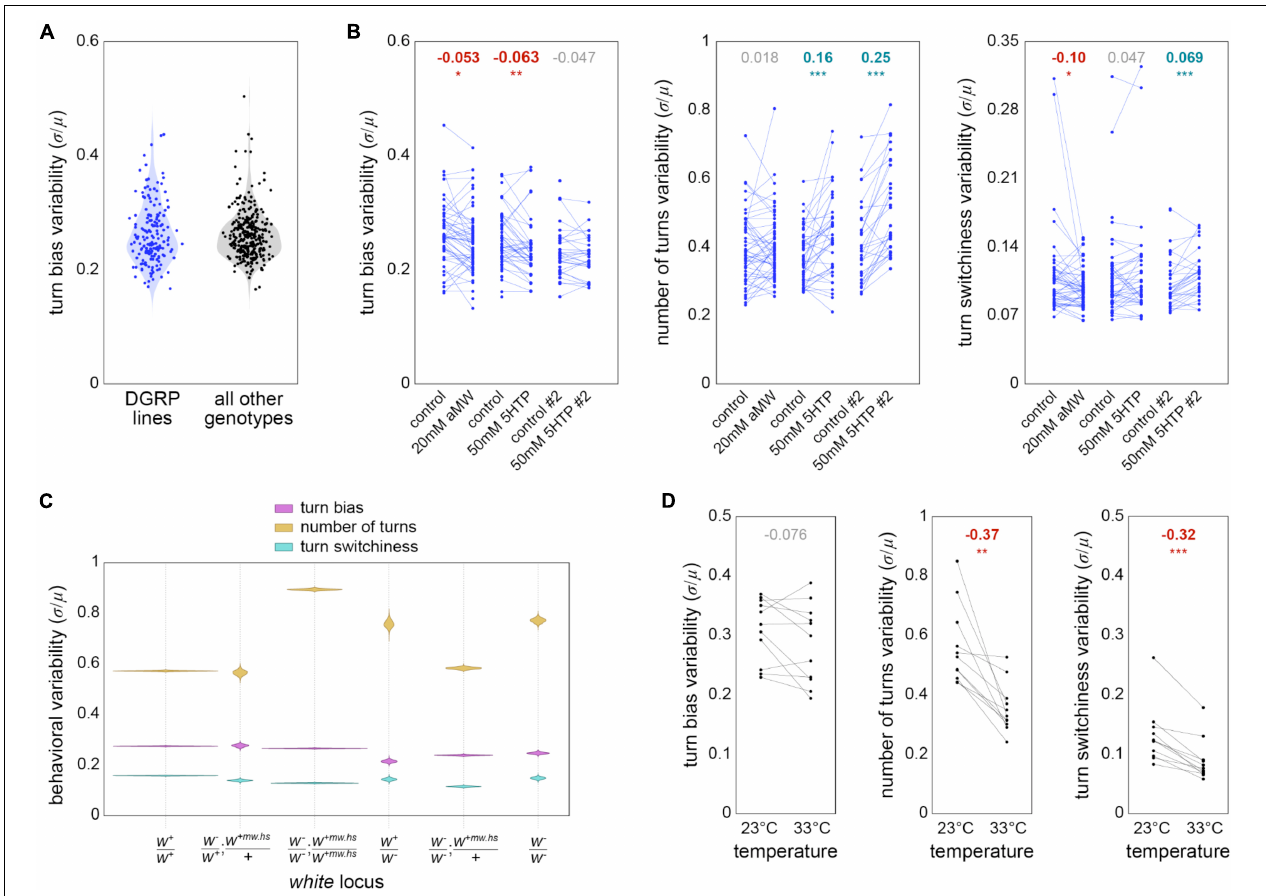
FIGURE 5 | Factors potentially affecting behavioral variability— (A) Variability (measured as the coefficient of variation) of turn bias for DGRP genotypes (blue; n = 223 genotypes comprising 64,838 flies) and non-DGRP genotypes (black; n = 3466 genotypes comprising 118,658 flies). Violins are the KDE of genotype variabilities (points). (B) Variability of turn bias (left), number of turns (middle), and turn switchiness (right) for DGRP genotypes in six pharmacological experimental conditions targeting serotonin. Each point is a genotype in a particular experimental condition. Lines pair genotypes across a drug medium and its associated control medium. Numbers at top indicate the effect size from control to drug treatment. Bold effect sizes are statistically significant and colored by the direction of their effect (red = lower variability; cyan = higher). * p < 0.05; ** p < 0.01; *** p < 0.001. n = 157 genotypes comprising 38,316 flies. (C) Violin plot of estimation distributions for the variability of turn bias (magenta), number of turns (gold) and turn switchiness (turquoise) vs. genotype of the white gene.+ indicates wild type, + mw.hs the “mini-white” allele typically used to mark a transgenic insertion, and - a null allele [typically w 1118 ; Hazelrigg et al. (1984)]. white genotypes are ranked in estimated order of expression disruption. The site of w + mw . hs insertion varied by line; the semi-colon notation in the panel label indicates that this site might be on a different chromosome than the endogenous w locus. n = 85,551, 1,863, 75,866, 1,484, 14,888 and 3,844 flies, respectively. (D) Variability of turn bias (left), number of turns (middle) and turn switchiness (right) for genotypes tested at 23 and 33 ◦ C. Lines pair genotypes across temperature conditions. n = 11 genotypes comprising 10,060 flies. Effect sizes and significances indicated as in panel (B)